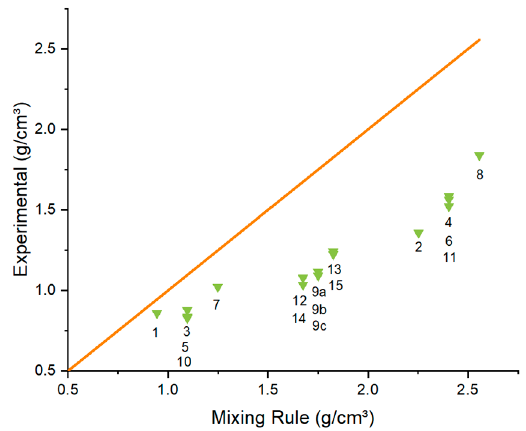
Figure 7. Densities of the compression moulded cubes as function of the densities according to the mixing rule (green) with the numbers on the graph representing the different samples (Table 1). The orange line indicates the perfect case that the mixing rule is valid.